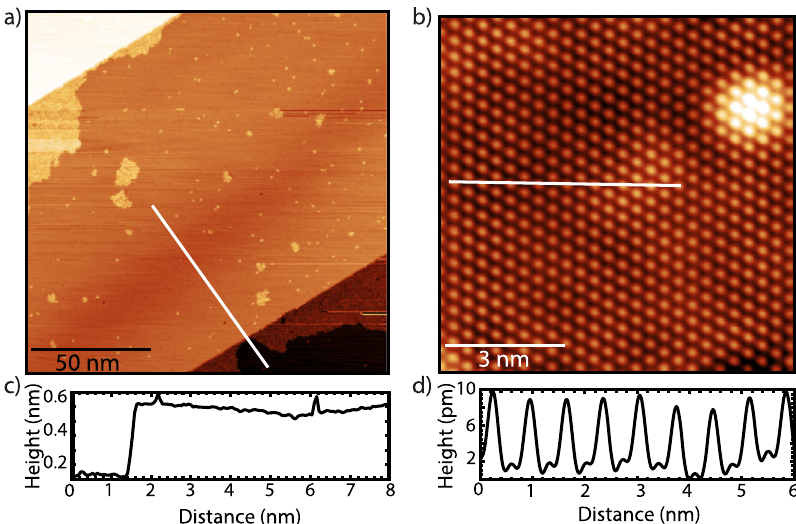
Fig. 2 STM images of PdTe 2 . a Large scale STM topographic image of the 1T-PdTe 2 surface ( V t = 1, V I t = 50 pA); b Atomically resolved STM image ( V t = 40 mV, I t = 1 nA). Both STM images were taken at 1.25 K; c Line pro fi le taken along the line in ( a ); d Topographic modulation along the line pro fi le following the white line in ( b